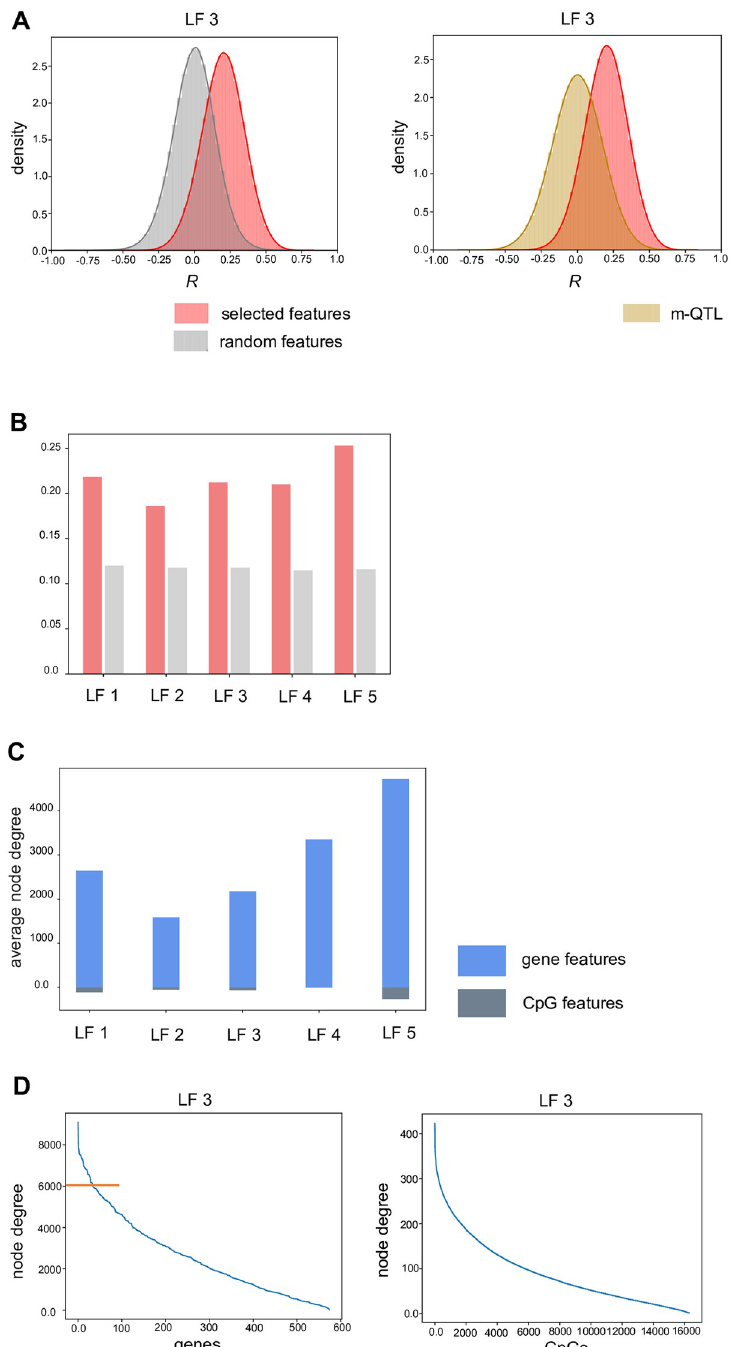
Fig 5. Distribution of the correlation coefficients for latent factor analysis and analysis of node degree of the resulting network. A) The figure represents the distribution of the correlation coefficients for the correlations analysis performed for selected gene and CpG features (for LF 3). This distribution is compared to a distribution obtained by random selection of gene and CpG features. It is also compared to the distribution obtained in the m-QTL analysis. B) The barplots represent the mean R for the latent factor analysis as compared to random background. C) Average node degree for gene and CpG features per latent factor is represented. D) The sorted node degree values for all gene and CpG features for latent factor 3 are shown. The orange line represents the 90 th percentile cut-off used for further analysis of high node-degree genes.